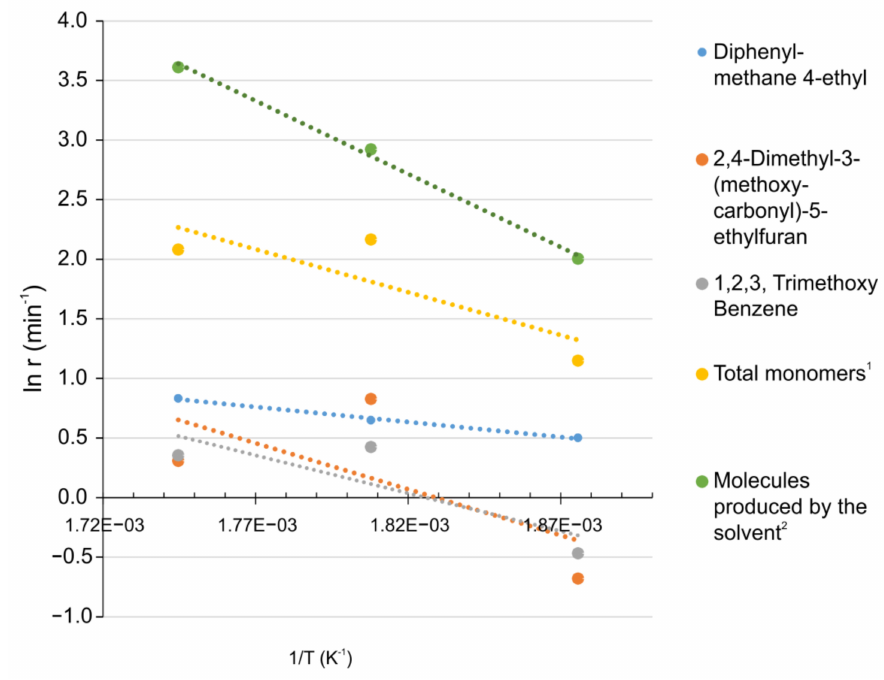
Figure 14. Arrhenius diagram of the catalytic conversion of lignin corresponding to a 90 min test.